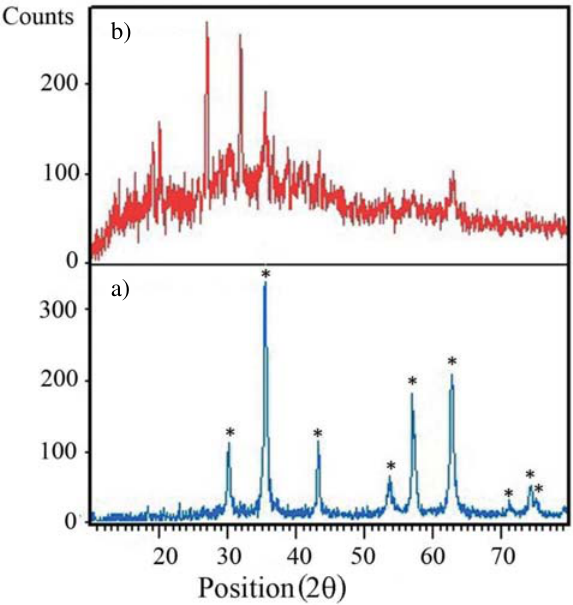
O nanoparticles (a) and 3 4 O (b). 3 4